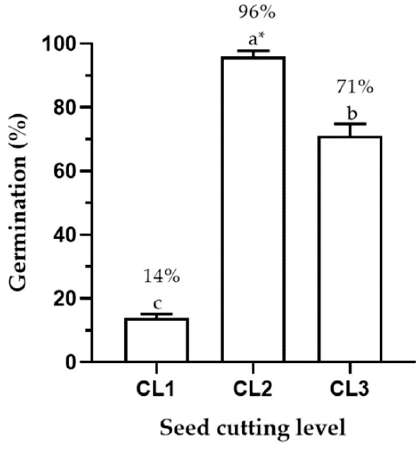
Figure 6. In vitro germination percentage of A. pelegrina seeds with different incision depths under the scarification treatment. CL1: control (intact, whole seed); CL2: transverse cut of the seed at the apex (opposite side of the hilum) to a depth of 0.1 to 0.5 mm; CL3: transverse cut at the apex (opposite side of the hilum) to a depth of 0.5 to 1 mm with embryo exposure. * Values with different letters in the graph indicate statistically significant differences, Tukey ( p ≤ 0.05). The bars represent the standard error.